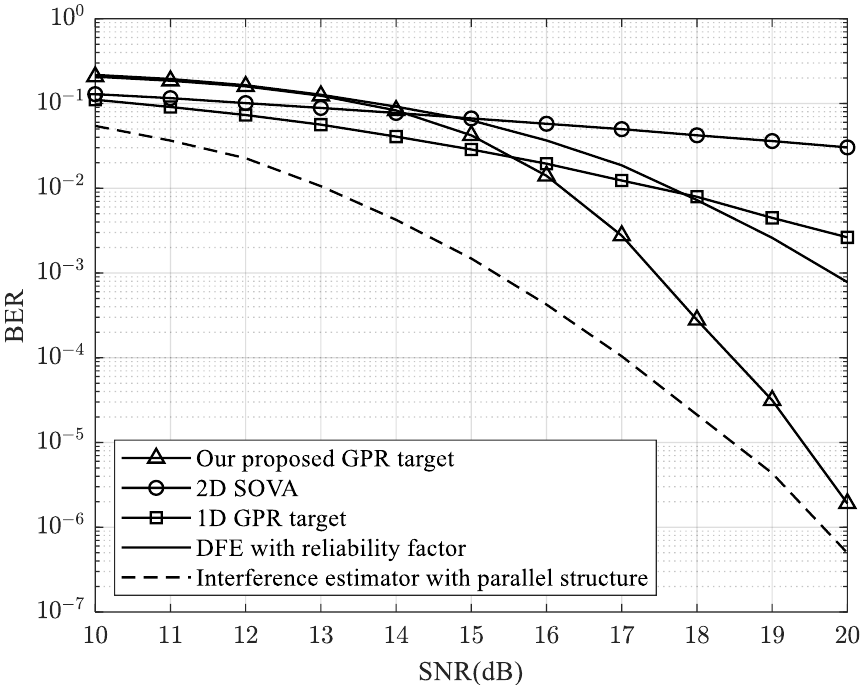
Figure 6. BER of the proposed 2D GPR target at 1.8 blur and 10% misalignment.